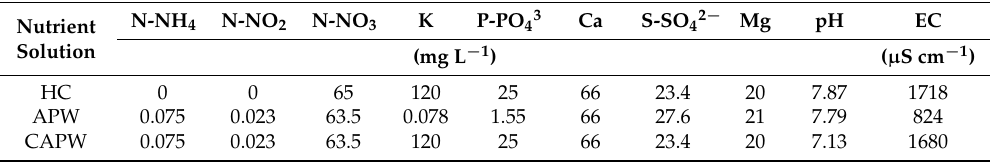
Table 1. Chemical composition of the nutrient solutions in the experiment (target values). CAPW: complemented aquaponic water; APW: aquaponic water; HC: hydroponic control; EC: electric conductivity.